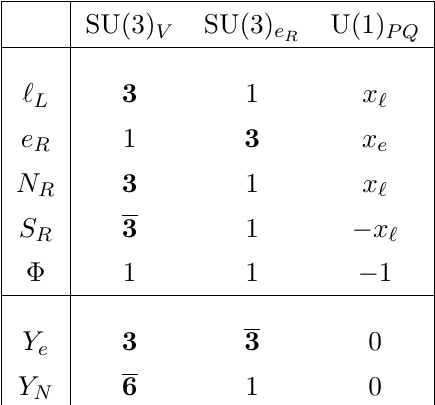
Table 6 . Transformation properties of the SM leptons, exotic neutral leptons and spurions under the global symmetries G SU(3) V F